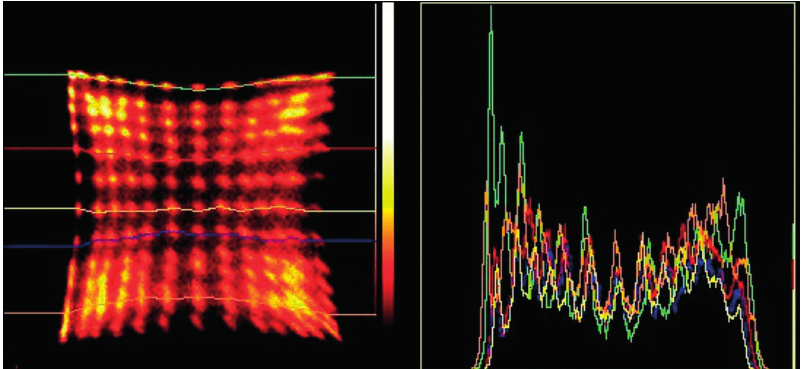
Figure 2. Crystal identification map from a Siemens HiRez 169 LSO crystal PET detector.